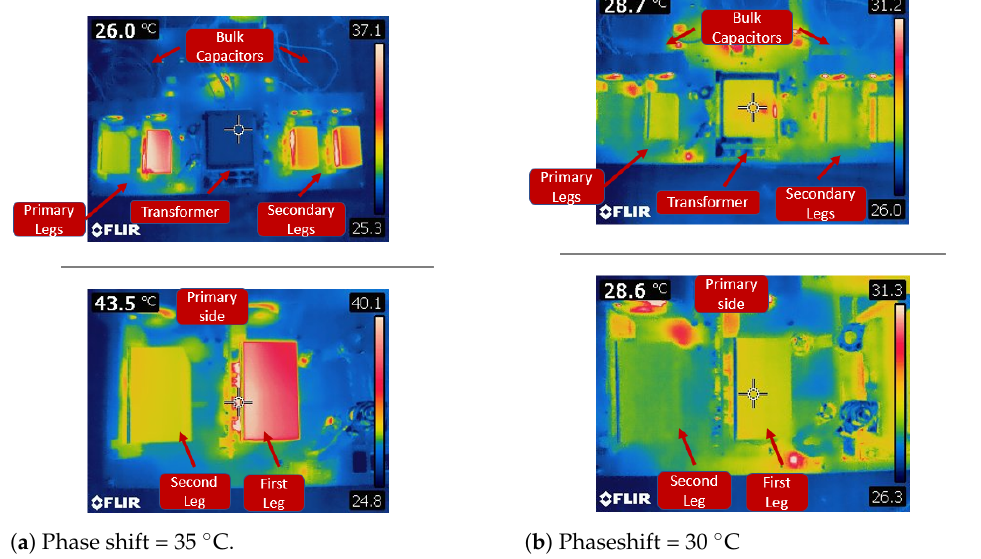
Figure 20. Thermal images of the prototype during V in = 100 V, R out = 22 Ω working